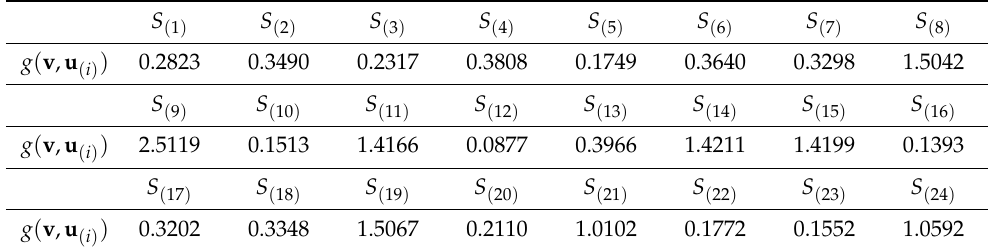
Table 4. The output results of the objective function values g ( v , u ( i ) )